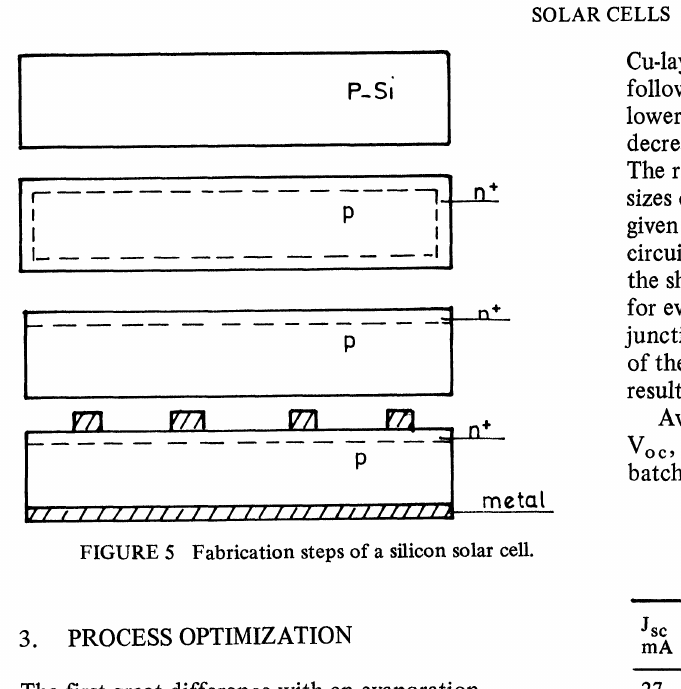
TABLE Best results on cells of 1/2 2 in. wafer.